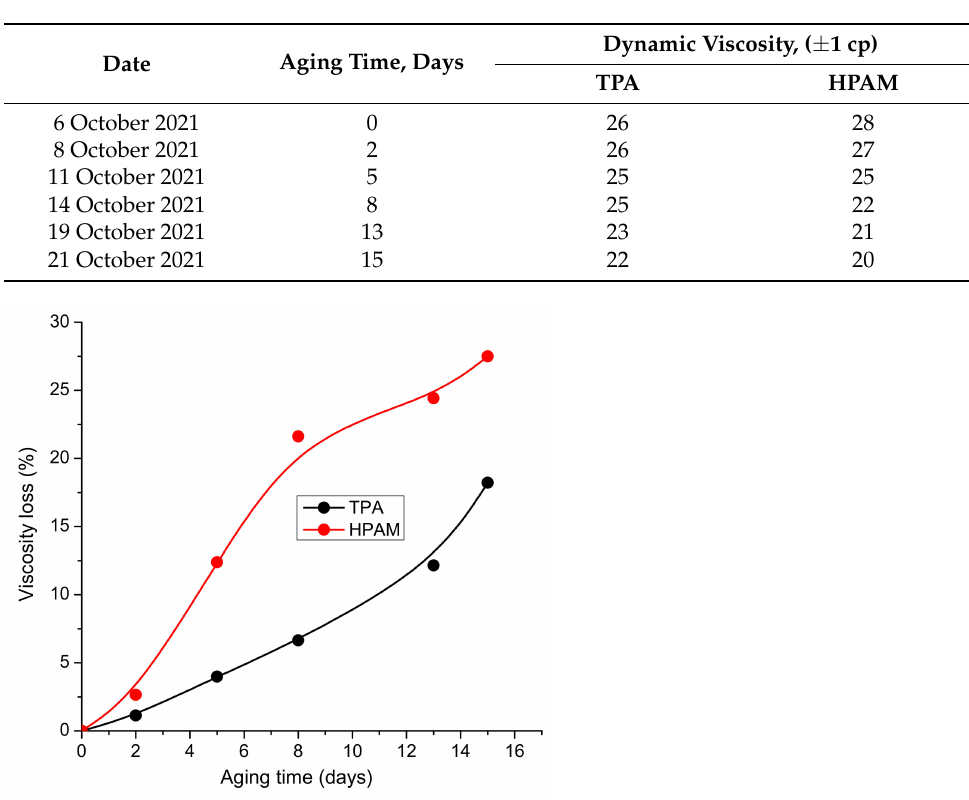
Figure 6. Dynamic viscosities of 0.25 wt.% TPA (curves 1 and 3) and HPAM (curves 2 and 4) in saline solutions at 24 ◦ C (curves 1 and 2) and 60 ◦ C (curves 3 and 4), with a shear rate of 7.32 s − 1 . Table 2. Viscosity of 0.25 wt.% TPA and HPAM solutions in 200 g · L − 1 synthetic brine while aging at 24 ◦ C.